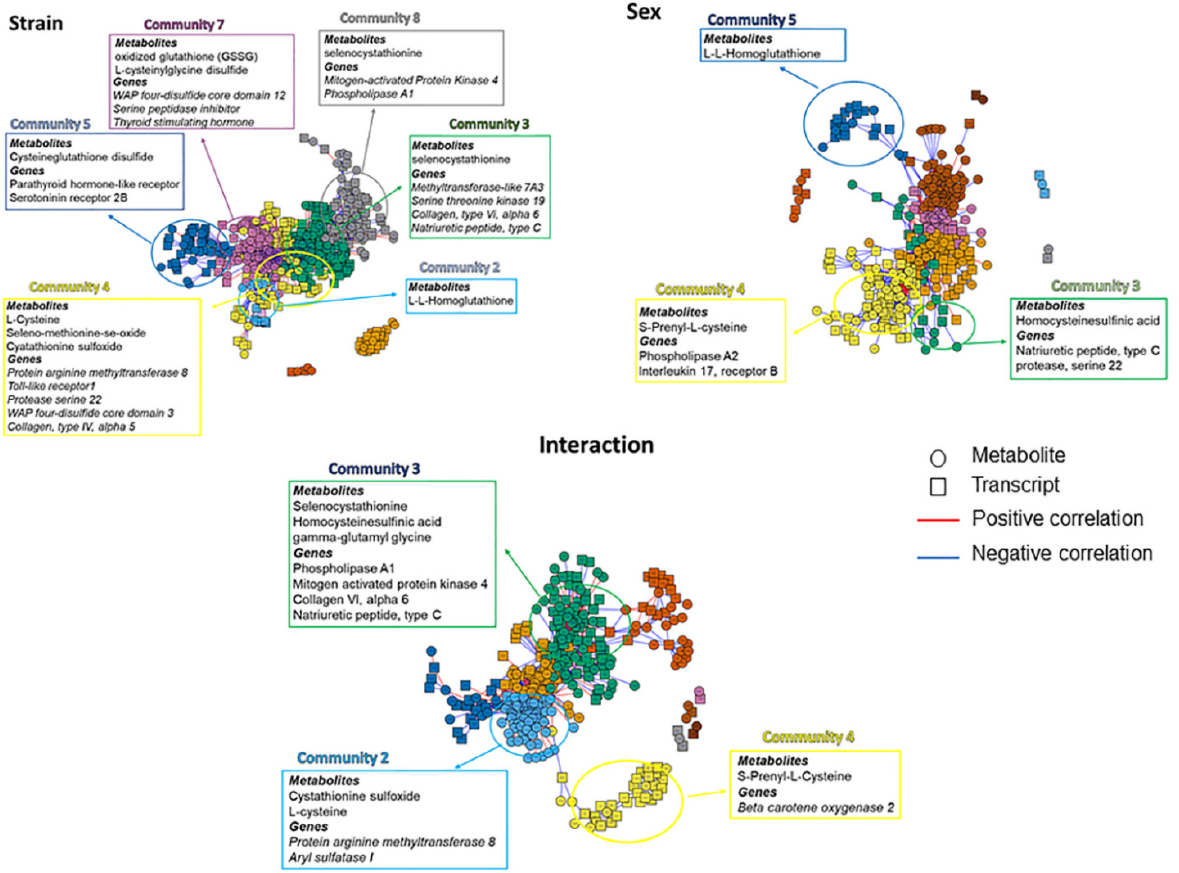
Figure 5. xMWAS analysis for interactions between metabolomic and transcriptomic data. Metabo- lites associated with oxidant/antioxidant pathways within specific communities were identified, and associated transcripts were searched using enriched data sets.